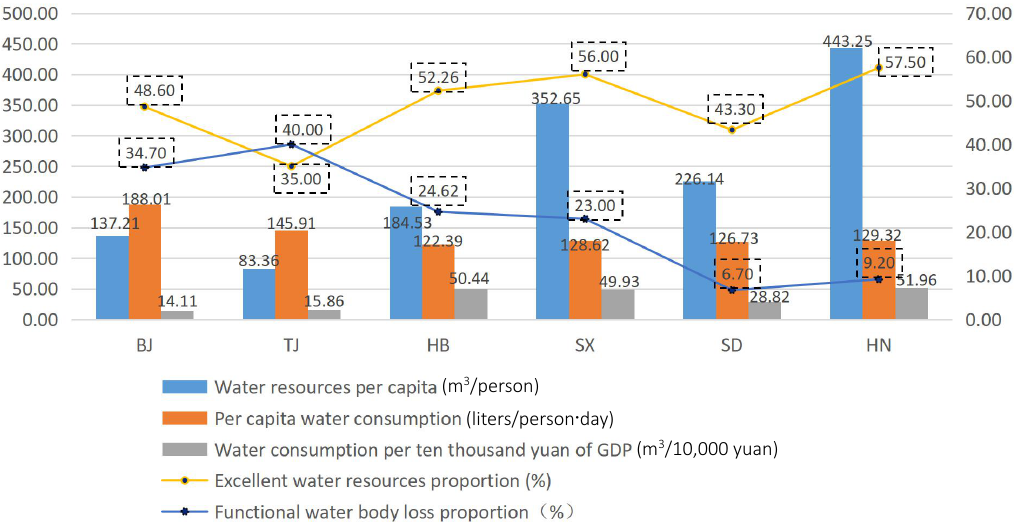
Figure 6. Situation of some indicators in North